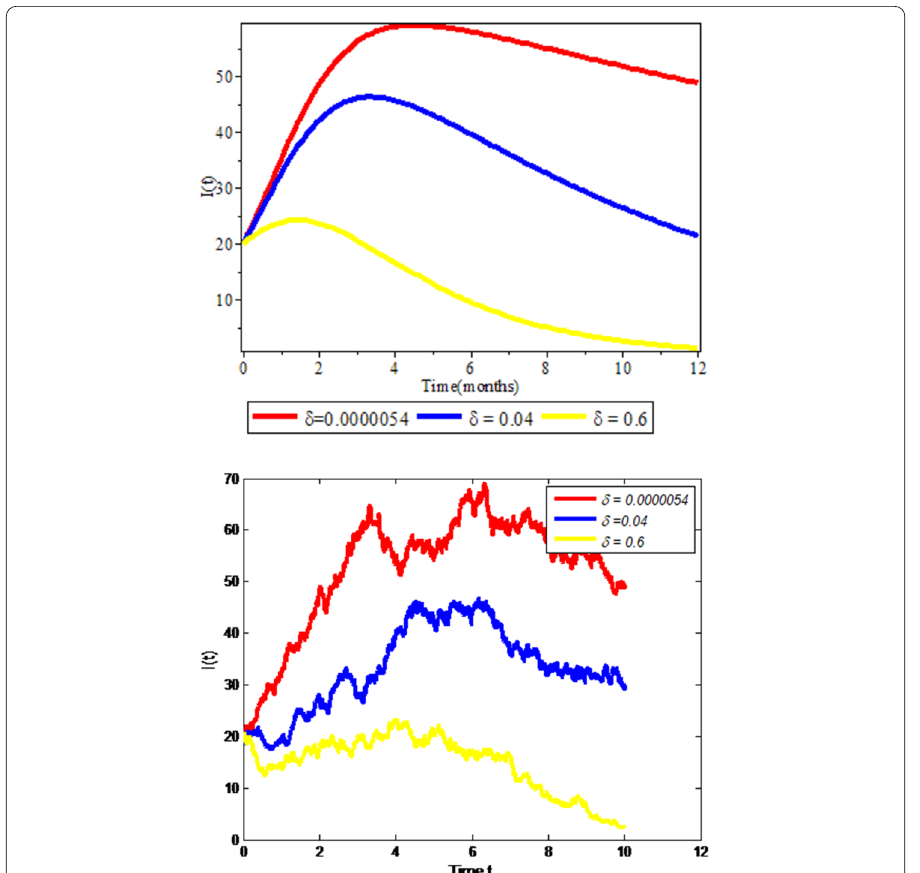
Figure 4 Effect of treatment rate on Covid-19 expansion